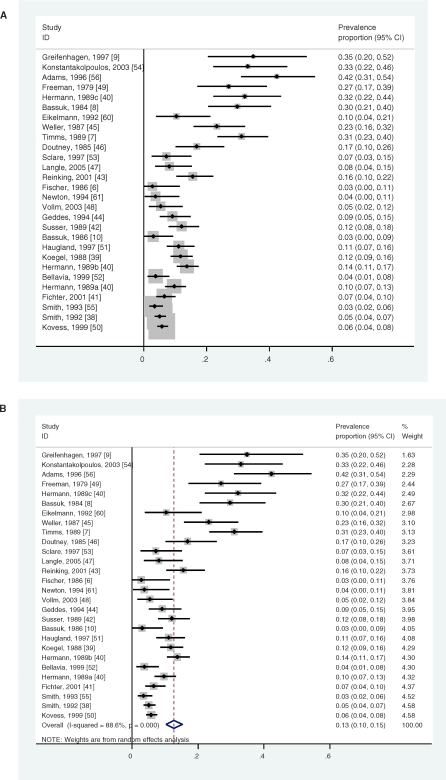
Prevalence of Psychosis in Homeless Persons(A) Studies are ordered by increasing study weight in a fixed effects model without calculation of an overall estimate.(B) Studies are ordered by increasing study weight and show the overall estimate calculated from random effects meta-analysis.